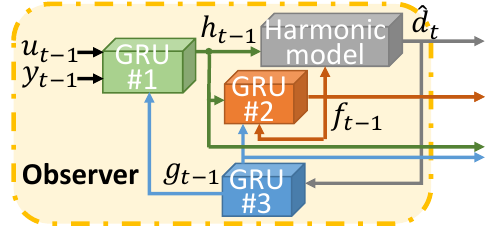
Figure 2. Observer network.